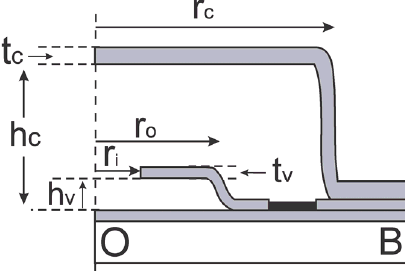
Figure 3. Partial cross-section of a fluid encapsulation device indicating key design parameters.